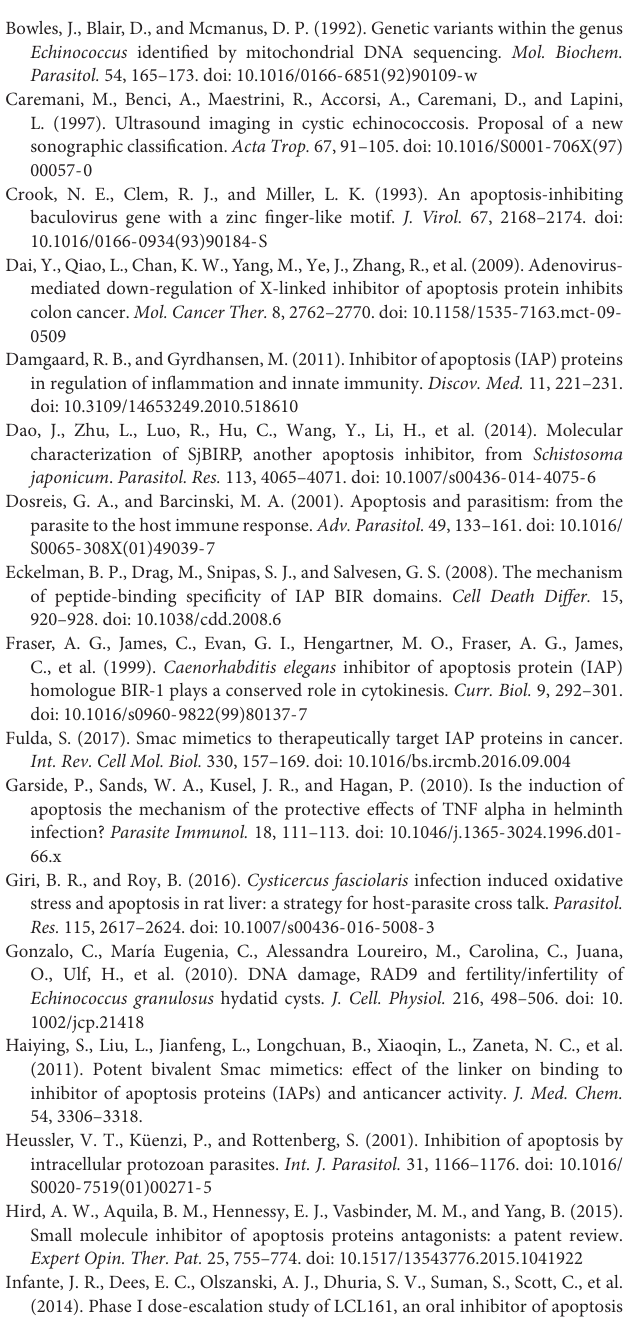
FIGURE S1 | Structure of 18-day strobilated worm under light microscope. Images of strobilated worm were magnified × 400. B, band; CC, calcareus corpuscles; EC, excretory canal; GR, genital rudiment; H, Hooks; R, rostellum; S, sucker; SG, segment. FIGURE S2 | Phylogenetic tree of Eg-IAP and Eg-BIRP using the Maximum- Likelihood (ML) method. GenBank accession numbers are shown after the species name.